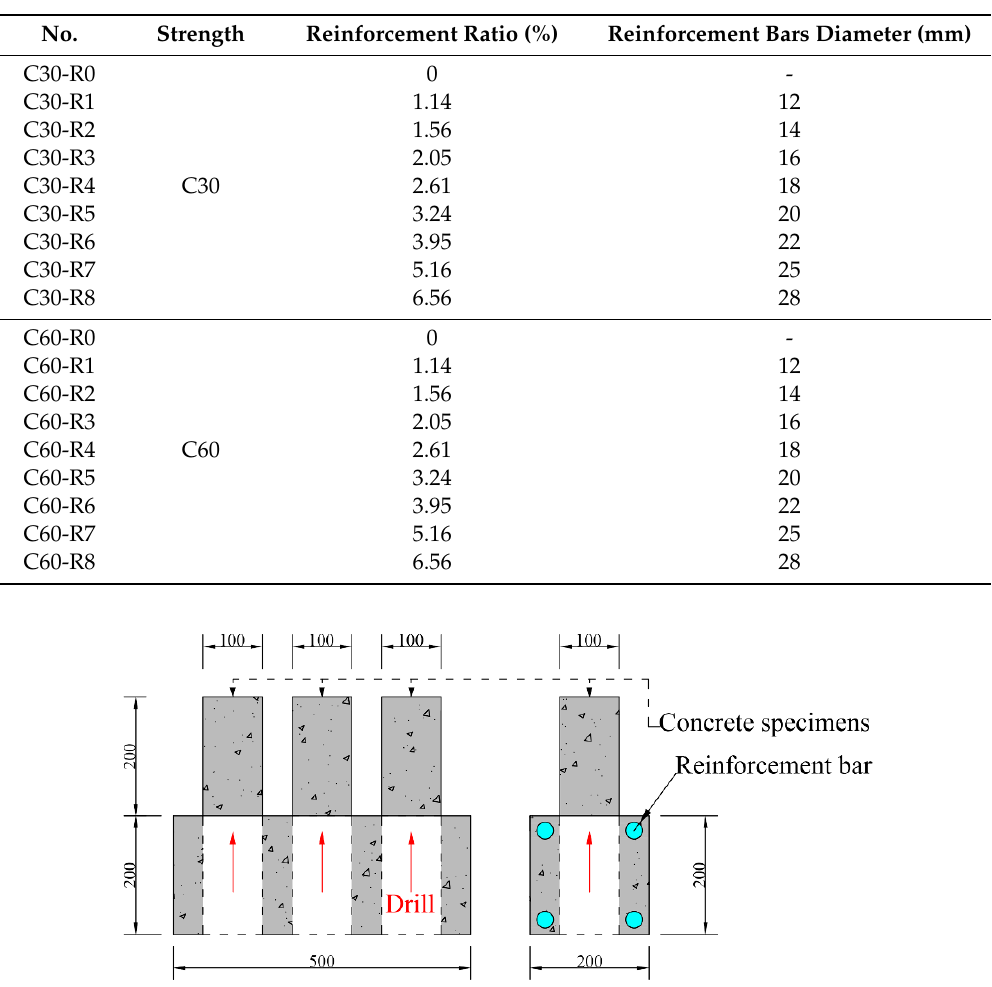
Figure 2. Specimen for measuring the pore structure and compressive strength of concrete (All dimensions are in